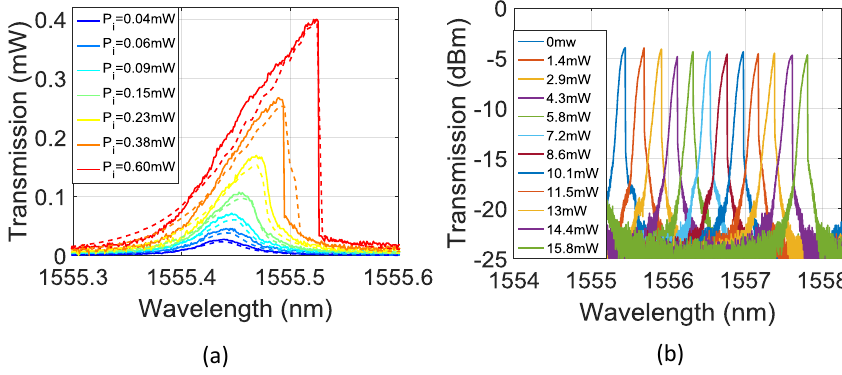
Figure 7. ( a ) Measured and simulated transmission spectra of the π -phase shifted grating as a function of on-chip injection power. Simulated curves are dashed lines, solid lines correspond to measured spectra; ( b ) Measured transmission spectra of the device at 0.6mW injection power as a function of the power dissipated on the thermal heating element (The y -axis is given in dBm in order to illustrate the asymmetric transmission spectra across the wide wavelength range).